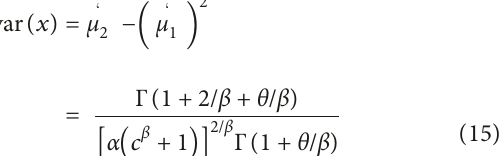
Figure 1: pdf and hazard rate of the NDWW